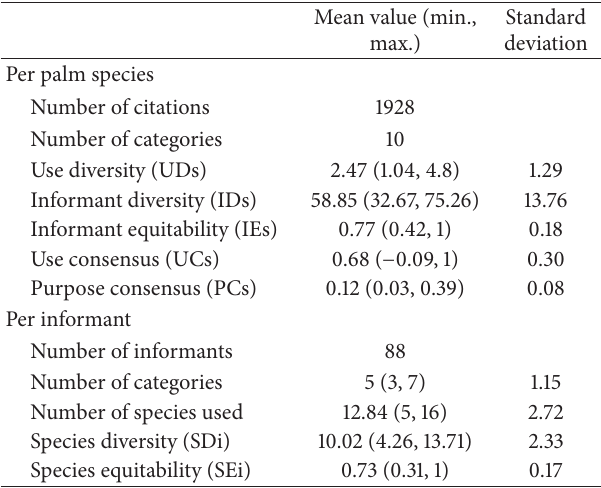
Table 6: Salience analysis calculated from the rankings of palm species by the Quilombo Kalunga of the Engenho II community, Cavalcante, GO, central western Brazil (in order of salience). IVs: importance values.